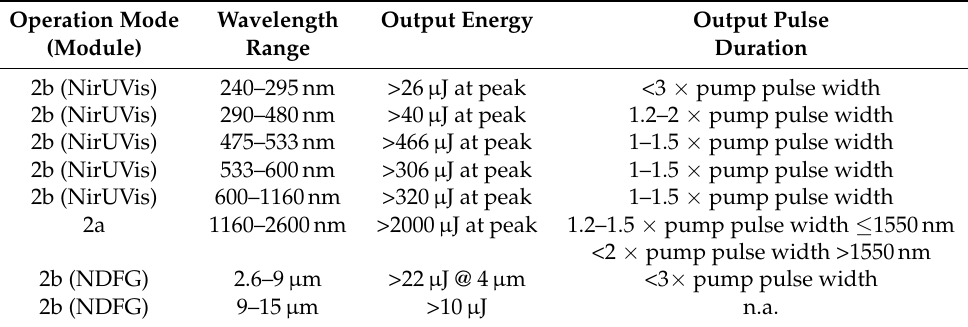
Table 2. Wavelength-dependent laser performance using the optical parametric amplifier (OPA) (mode 2a and 2b), typically pumped with 30fs, 8mJ